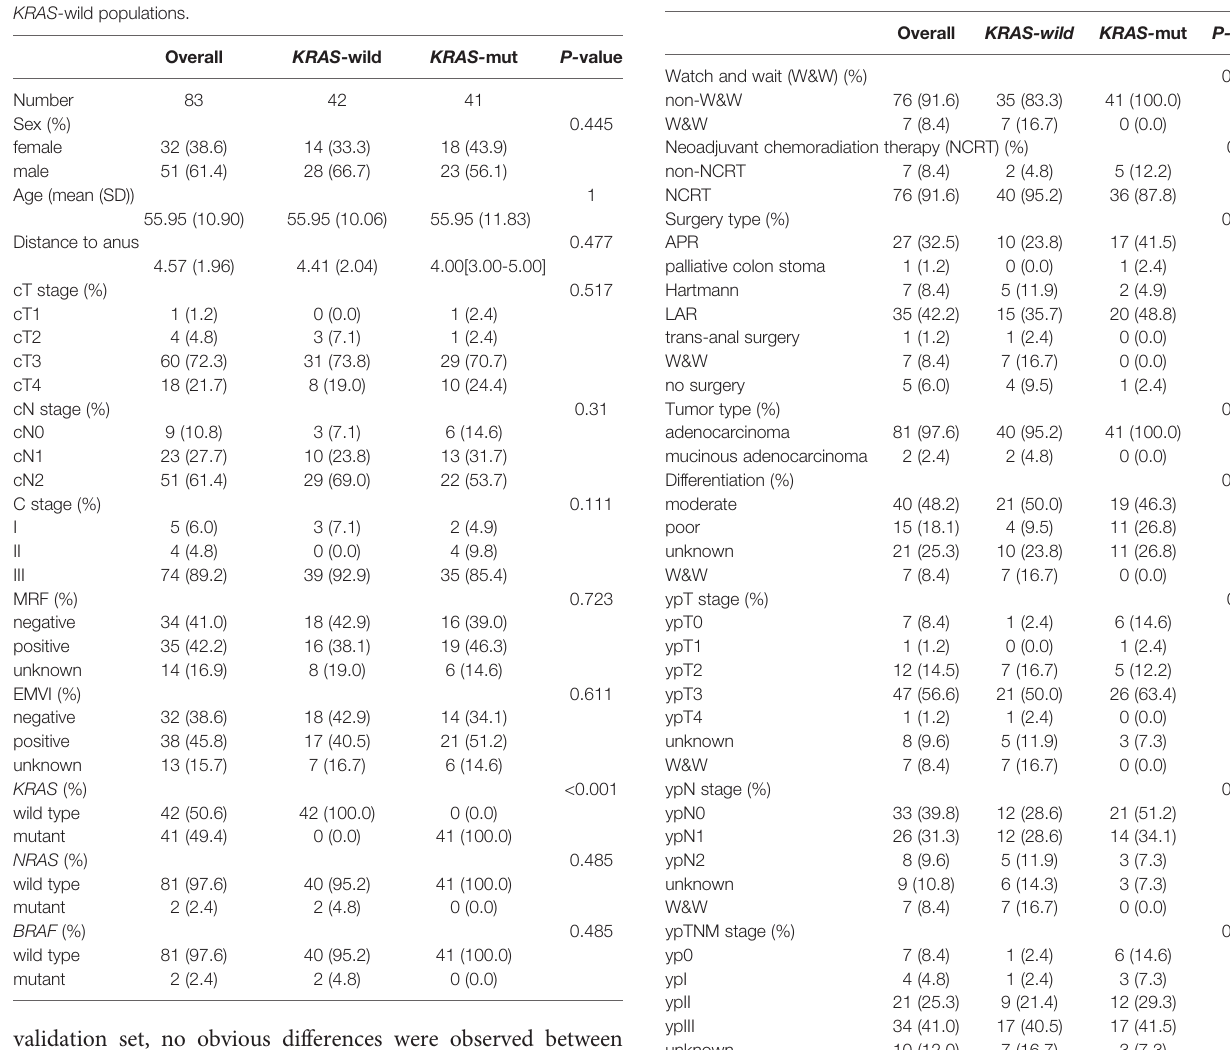
TABLE 2 | Patient treatments and pathological characteristics.